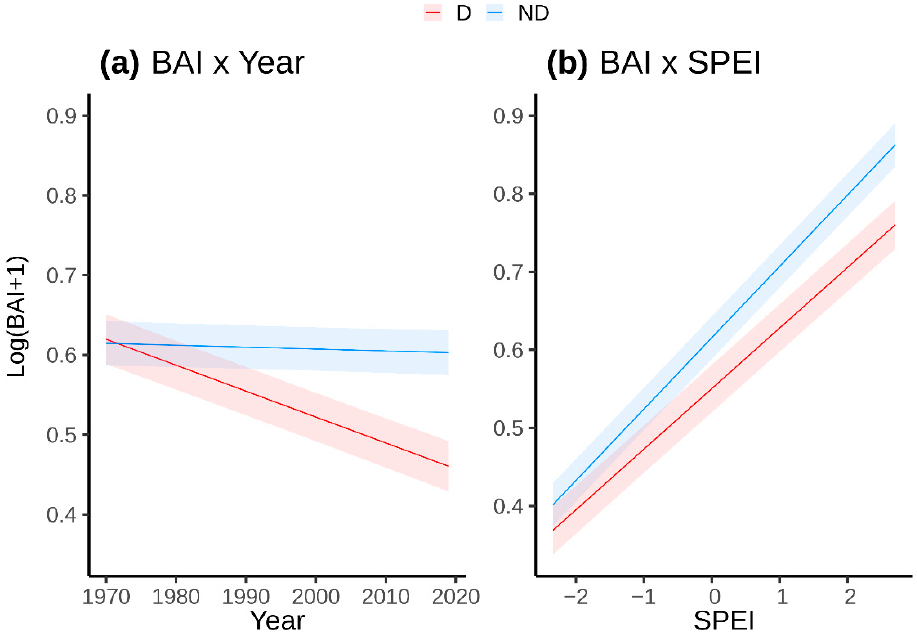
Figure 5. Modelled interactions on basal area increment as a function of ( a ) time and ( b ) the SPEI drought index for dead (D, red lines and areas) and living (ND, blue lines and areas) trees. Lines show the estimated effects, and the areas show standard errors.